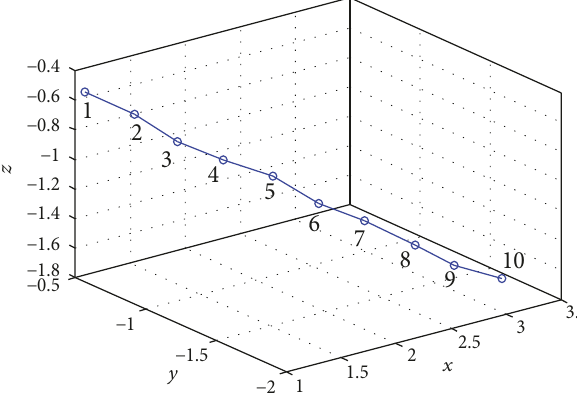
Figure 12: Triaxial expected control